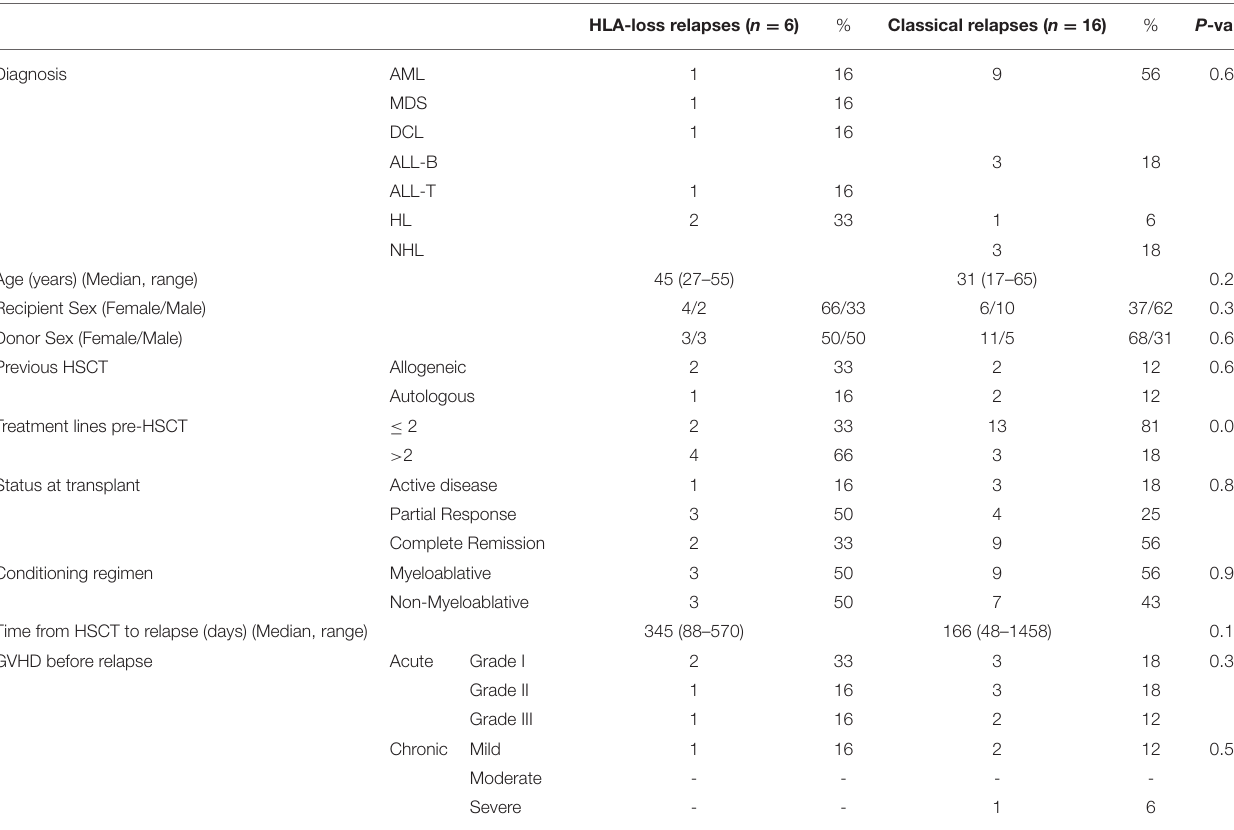
TABLE 2 | Clinical characteristics of 22 patients relapsed after Haplo-HSCT with